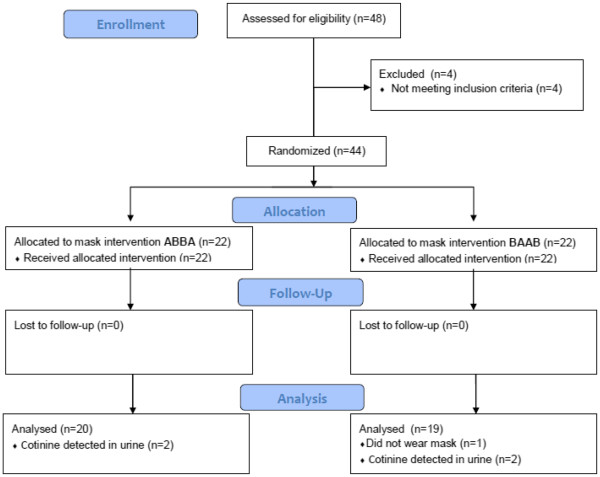
CONSORT flow diagram.